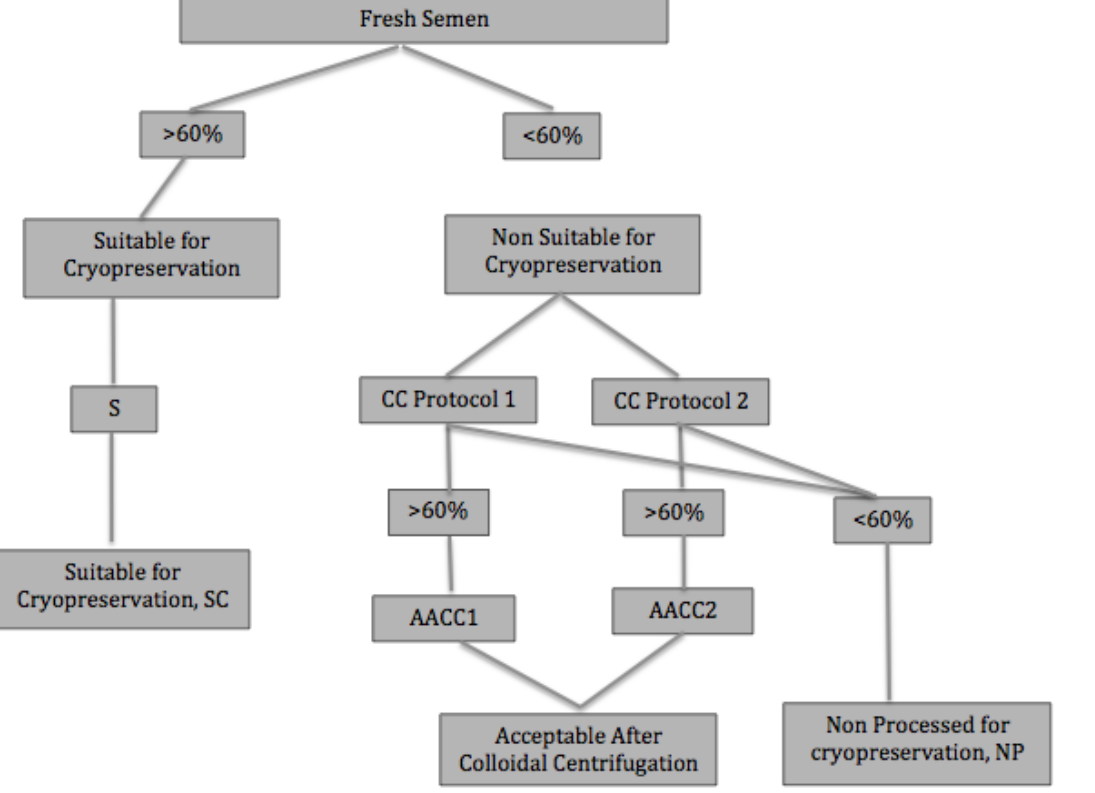
Figure 1. Semen centrifugation protocols. S: simple centrifugation (10 mL extended semen (1:1, v:v in Inra96 ® ); 450 g for 7 min); CC: colloidal centrifugation protocol 1 (10 mL extended semen (1:1, v:v in Inra96 ® ) over 10 mL of Bottom Layer ® ; 300 g for 20 min) and Protocol 2 (5 mL raw semen over 5 mL of Bottom Layer ® ; 300 g for 20 min); SC: suitable for cryopreservation; AACC: acceptable after colloidal centrifugation; AACC1: acceptable after Colloidal centrifugation with Protocol 1; AACC2: acceptable after colloidal centrifugation with Protocol 2.